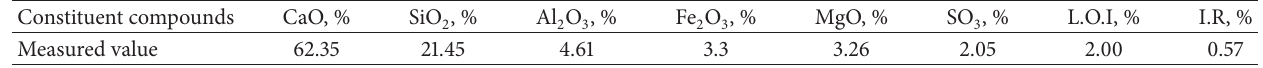
Table 1: Chemical contents of type I cement, according to national standard no. 389 (Tehran Cement).